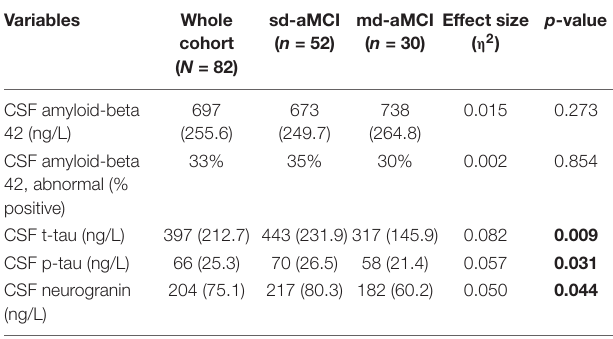
TABLE 4 | Conventional and synaptic CSF biomarkers in the whole MCI cohort and sd-aMCI and md-aMCI subgroups. Variables